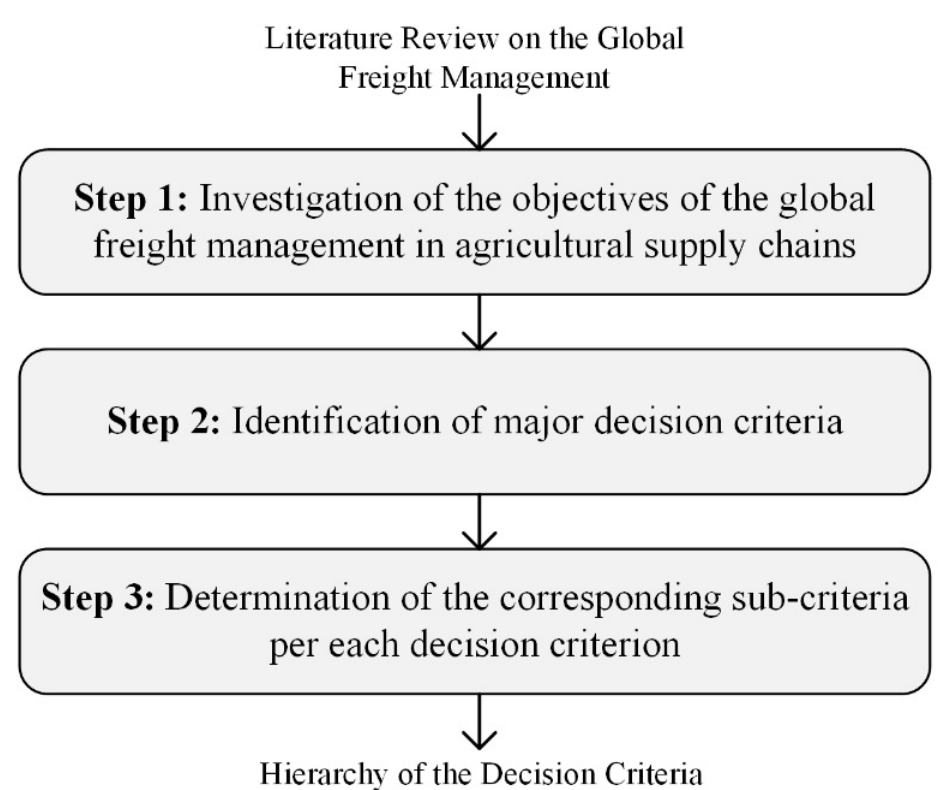
Figure 2. Procedure to formulate the decision-criteria hierarchy.